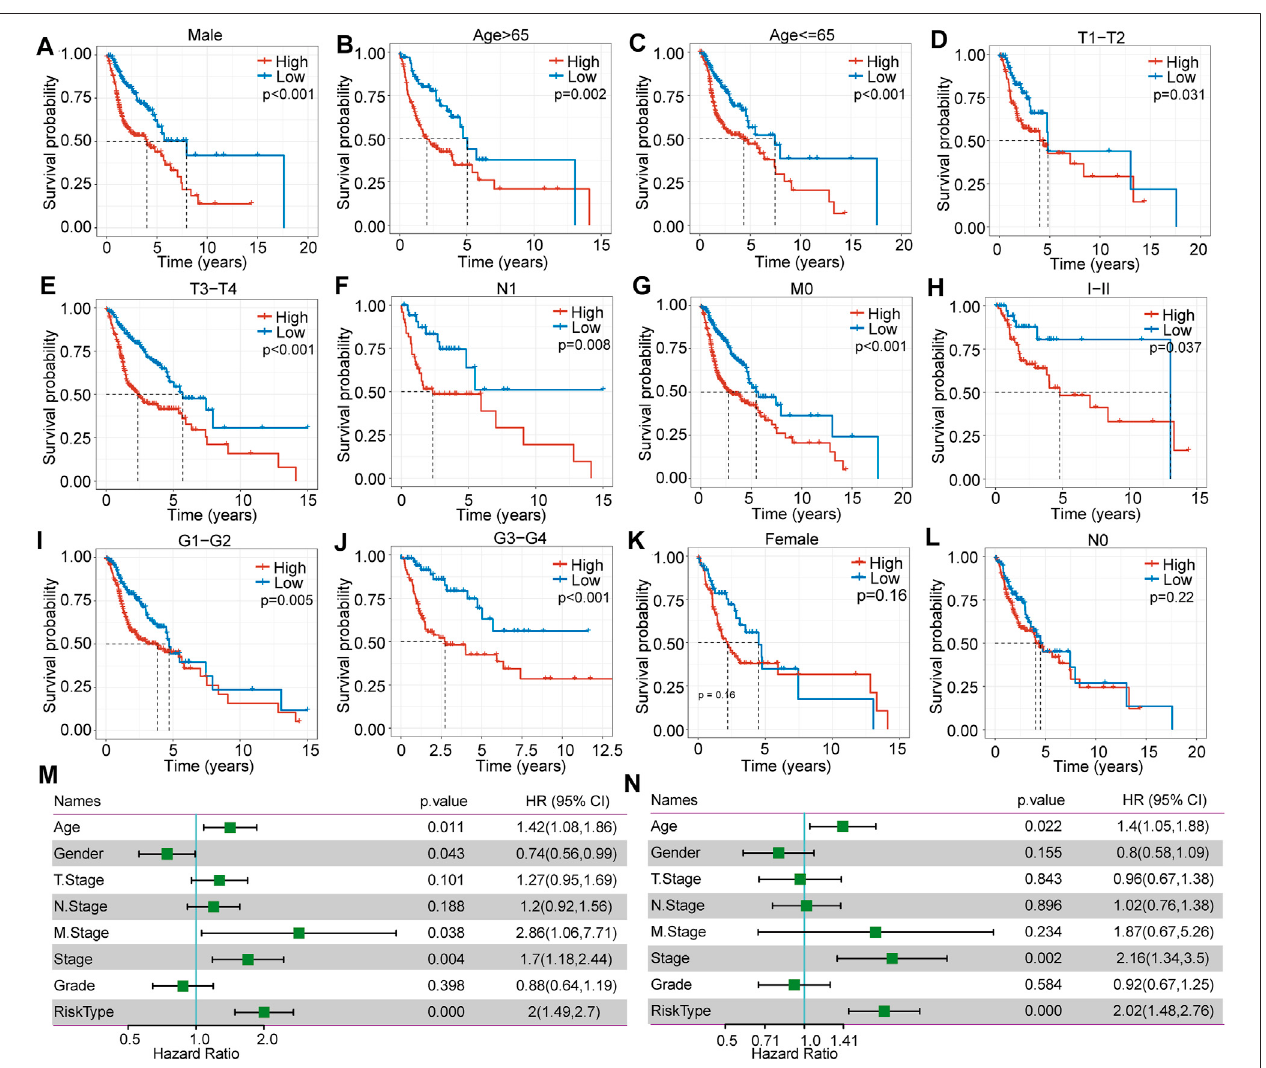
FIGURE 4 | The difference in clinical signature-based prognosis between high- and low-risk score subgroups in TCGA-HNSC. (A – L) The overall survival comparison between the high- and low-risk score subgroups with regard to female, male, age > 65, age ≤ 65, T1-T2, T3-T4, N0, N1, M0, MI-MII, G I-II, and G III-IV. (M) Correlationsbetween clinicalfeatures and riskscorethroughunivariate regression analysis. (N) Correlationsbetweenclinicalfeaturesand riskscorethroughmultivariate regression analysis.